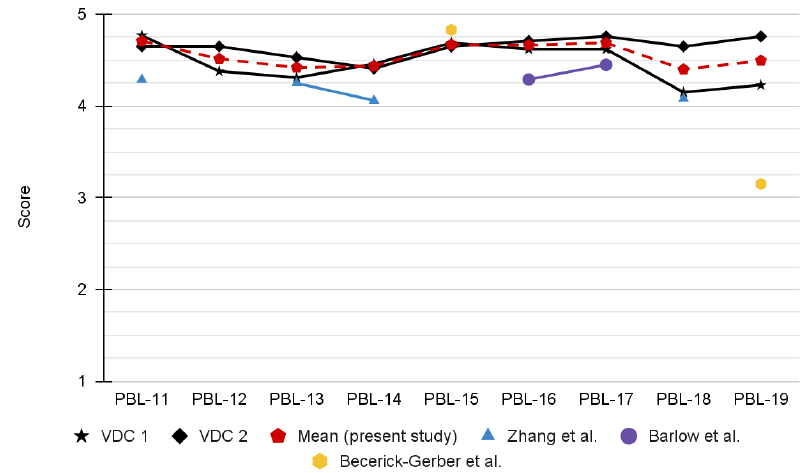
Fig. 7. Survey results on students’ perceptions of the learning methodology in VDC I and VDC II courses and study cases